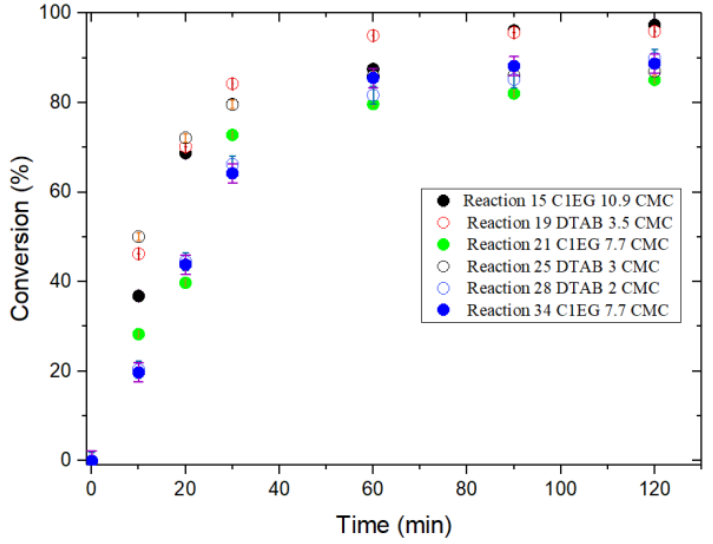
Figure 3. Evolution of monomer conversion for EP of St with IL C1EG and DTAB as emulsion stabilizers at 70 °C.